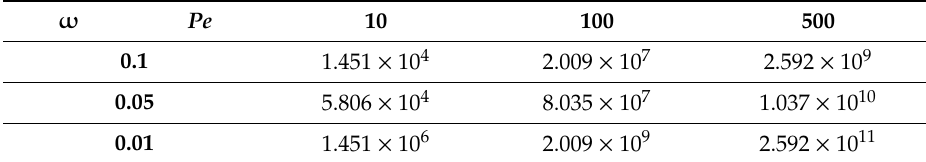
Table 2. Decay time of the ratio of two-particle to one-particle covariance. Pe: P é clet number; ω : decay